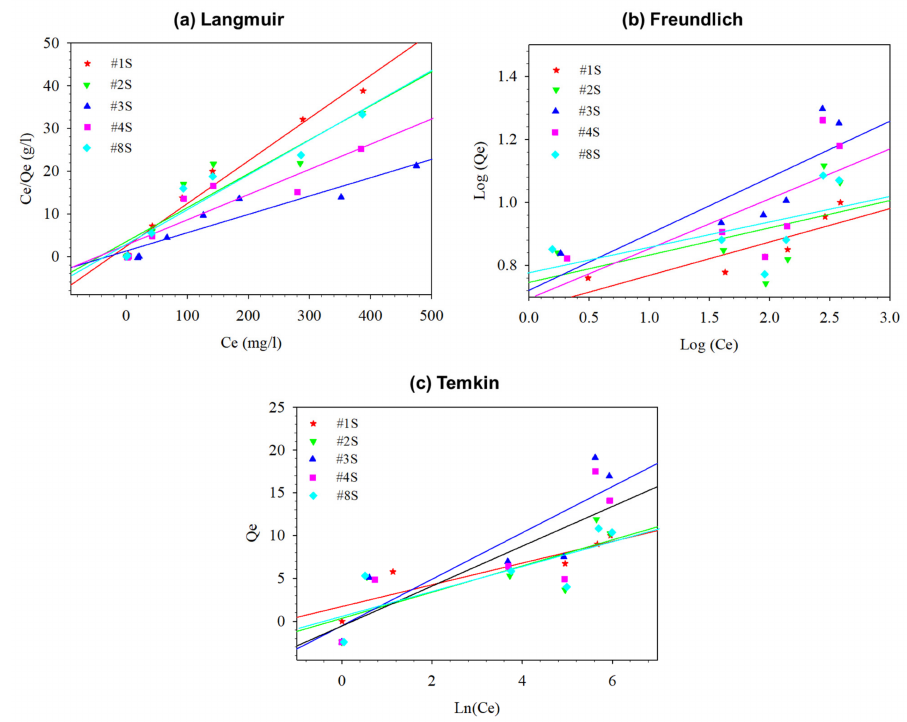
Figure 8. The plotted isotherm models of ( a ) Langmuir, ( b ) Freundlich, and ( c )